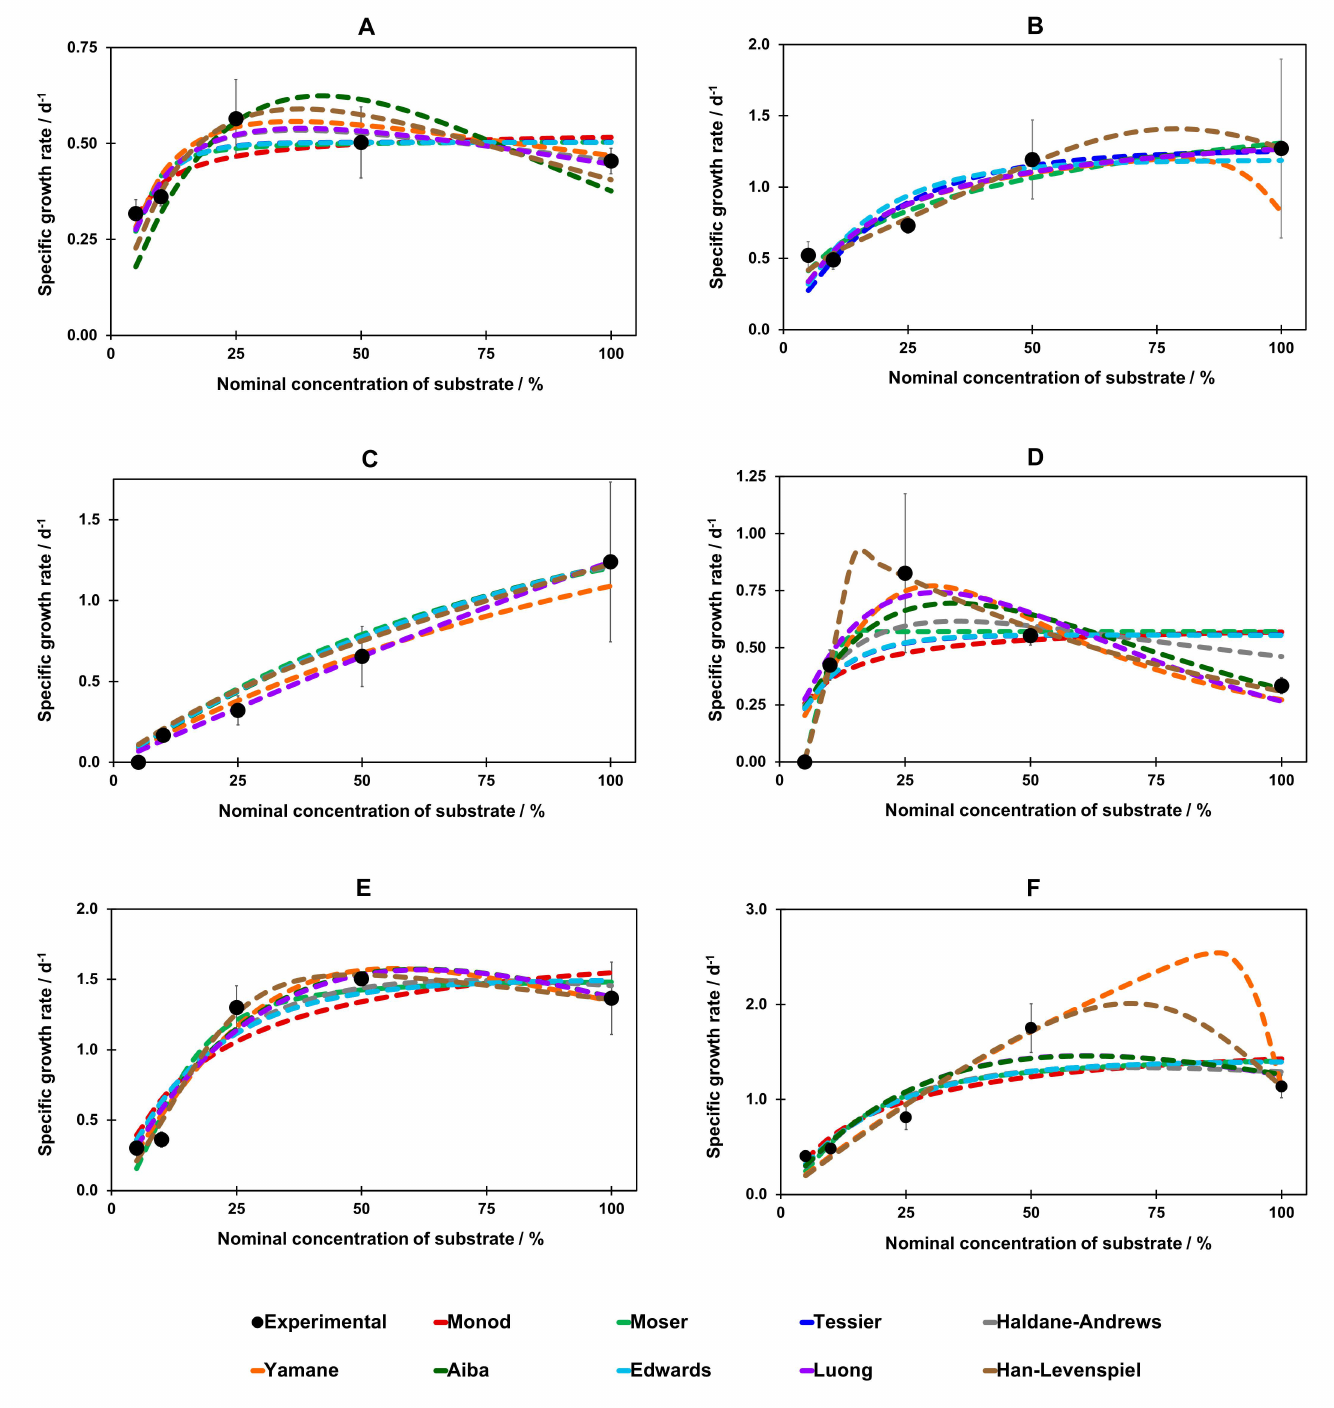
Figure 5. Graphical presentation for fitting all nine mathematical models for A. mellea on: ( A ) CSL, ( B ) DDGS; P. chrysosporium on: ( C ) CSL, ( D ) DDGS; P. ostreatus on: ( E ) CSL, ( F ) DDGS. Abbreviations: CSL—corn steep liquor; DDGS—dried distillers grains with solubles. 100% CSL: CSL with nominal concentration of 5.27% w / v ; 100% DDGS: DDGS with nominal concentration of 7.44% w / v ; 50% CSL or DDGS: CSL or DDGS at 50% of nominal concentration of 100% CSL/DDGS